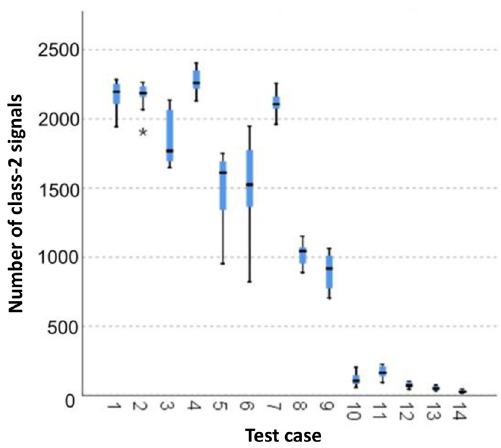
Figure 5. Graphic presentation of the Kruskal–Wallis test results for independent samples: number of class-2 signals.